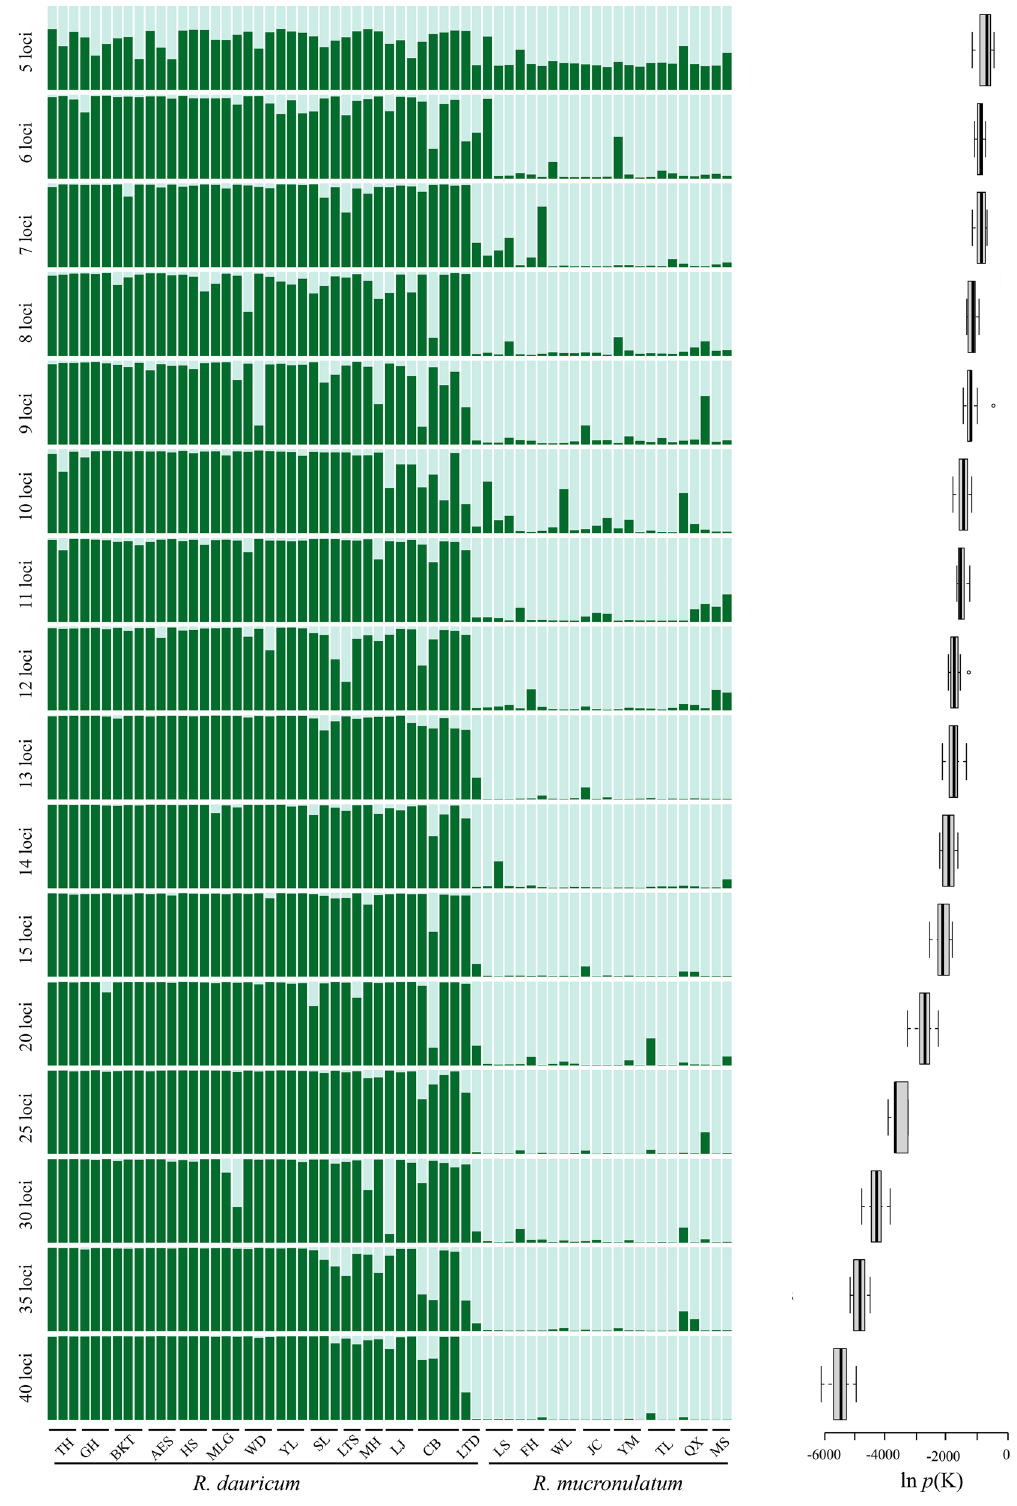
Figure 4. STRU CTU RE results (left) and the mean Ln p (K) values (right) of different number of loci when K = 2